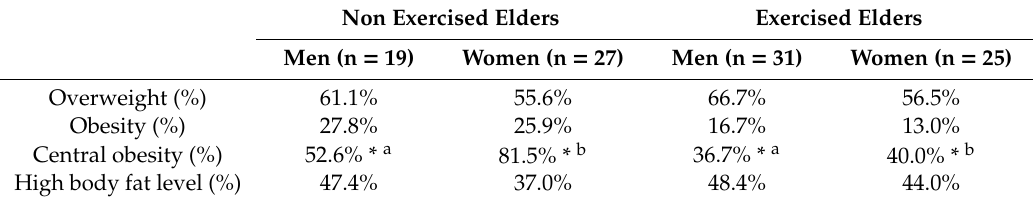
Table 5. Percentage of obesity, central obesity and elevated fat levels, according to gender and exercise. Non Exercised Elders Exercised